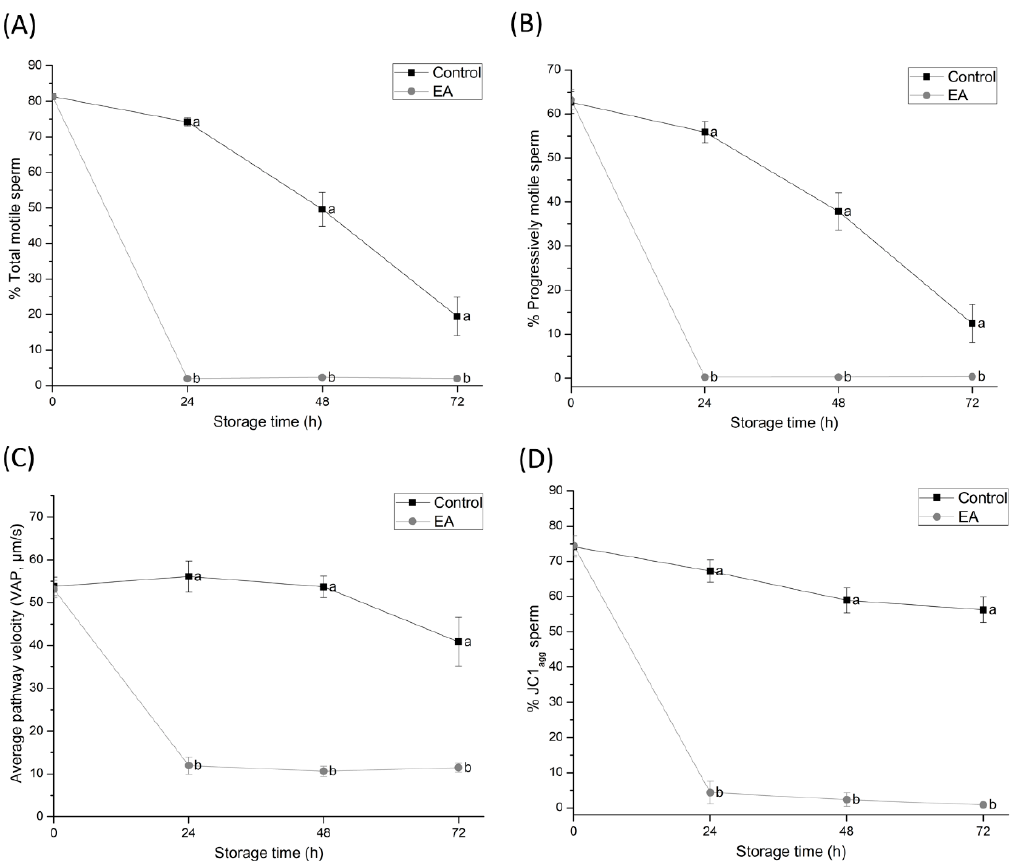
Figure 1. ( A ) percentages of total motile sperm, ( B ) percentages of progressive motile sperm, ( C ) average pathway velocity (VAP; μ m/s), and ( D ) percentages of high ΔΨ m sperm (JC1 agg sperm) of semen samples treated with ethacrynic acid (EA), a glutathione S-transferases (GSTs) inhibitor, and the control group, assessed at different evaluation times during liquid storage at 17 °C (0, 24, 48, and 72 h). Different letters (a, b) indicate significant differences ( p < 0.05) between treatments within storage